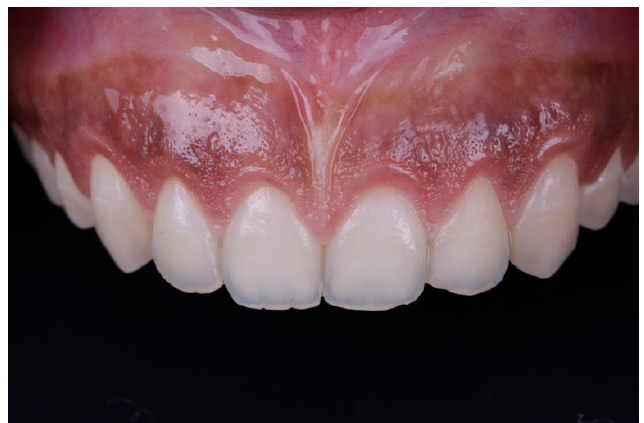
Figure 10. At 10-day follow up.